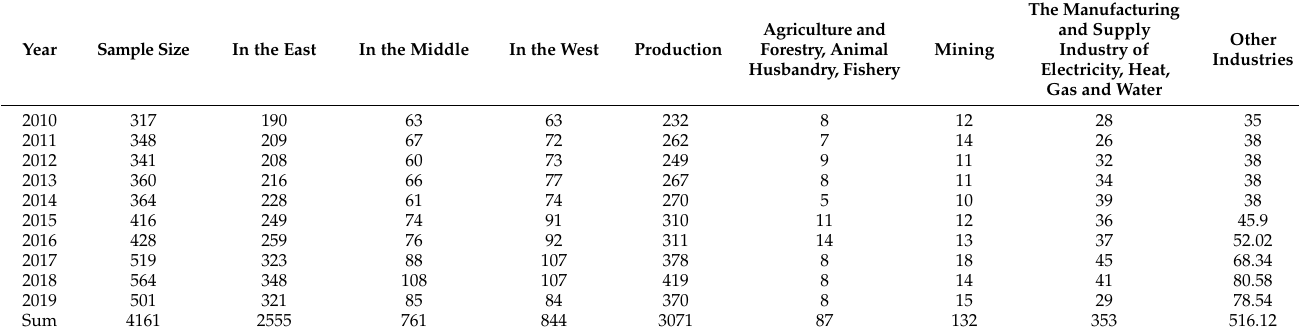
Table 1. Annual, regional and Industry